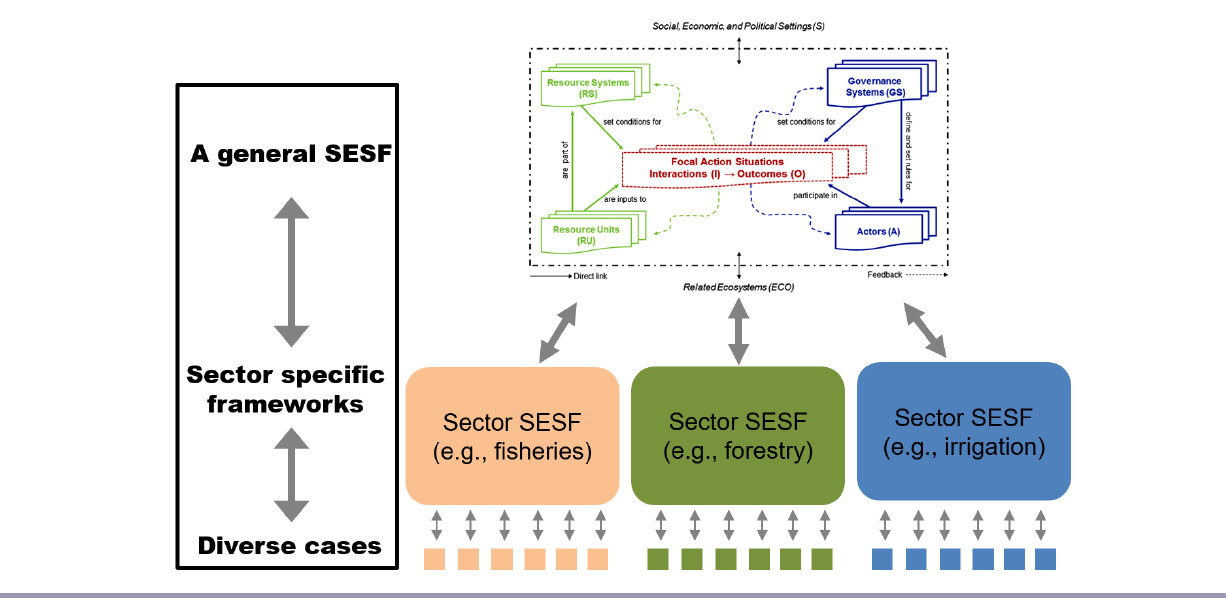
Fig. 3. Conceptualizing the potential evolution of the SESF. Application of the framework to case studies contributes new variables and data to specific resource-use sectors (e.g., small-scale fisheries, forestry, irrigation). Different sectors may evolve separate versions of the SESF. Commonalities between all sectors contribute to the development of the general framework. Theory building may follow a similar path. General theory building across sectors would be informed by cross-sectoral